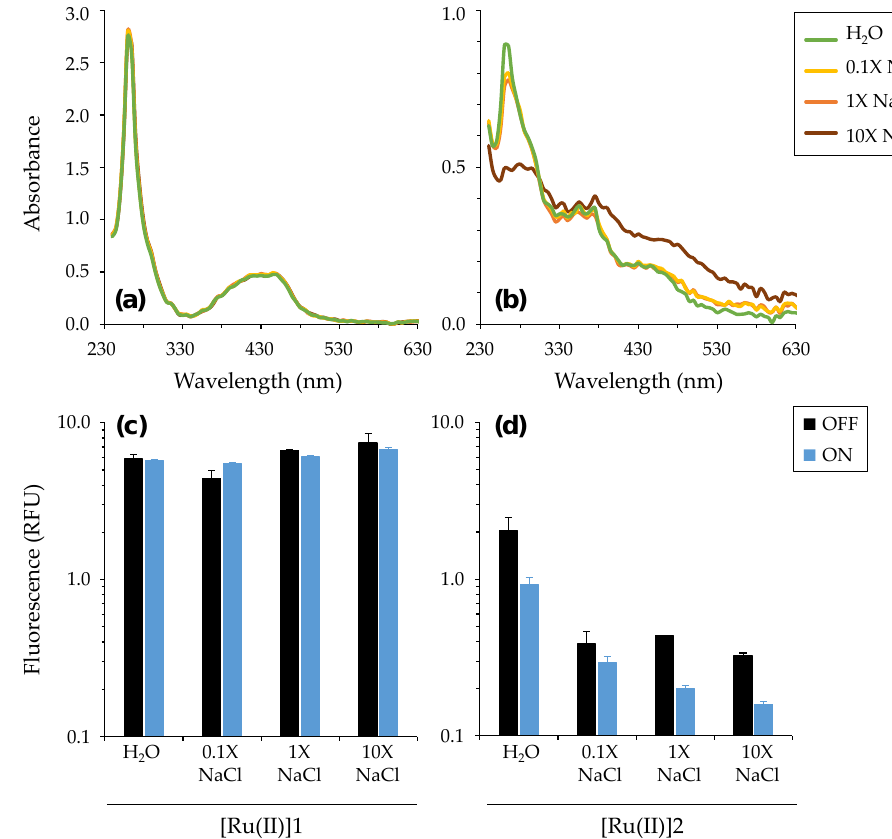
Figure 3. Photophysical properties of [Ru(II)] in water or in saline solutions. Absorption in the UV-visible spectrum ( a , b ) and fluorescence ( c , d ) were determined with [Ru(II)]1 ( a , c ) and [Ru(II)]2 ( b , d ). In every test, [Ru(II)] concentration was 50 µM in 200 µL. Fluorescence measurements were performed before (OFF) then after (ON) light treatment. Mean ± SD with n = 3. The fluorescence background is ~0.05 RFU in every case. “RFU”: relative fluorescence unit.